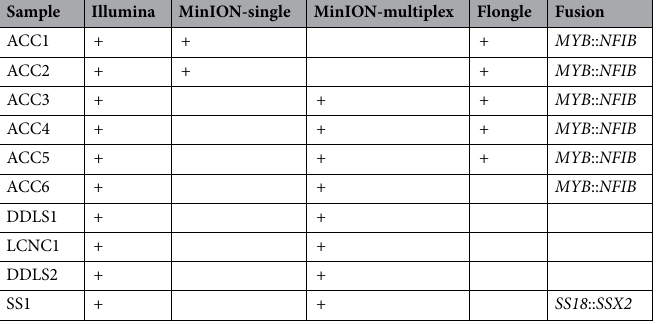
on chromosomes X and Y, the mitochondrial genome, as well as rRNA and tRNA genes were omitted as they are likely to introduce library size estimation biases. All computations were performed on a high-performance compute cluster.